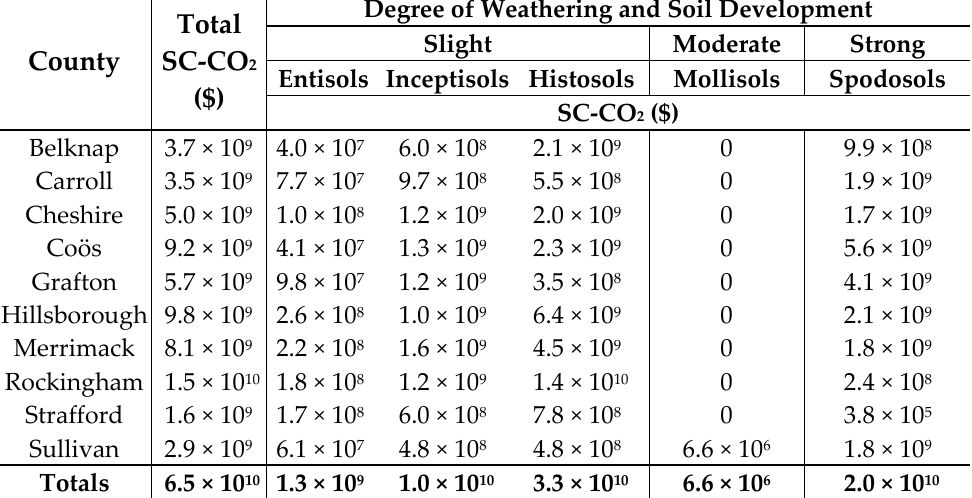
Table 6. Monetary value of soil organic carbon (SOC) by soil order and county for the state of New Hampshire (USA), based on the areas shown in Table 3 and the area-normalized midpoint monetary values shown in Table 4.